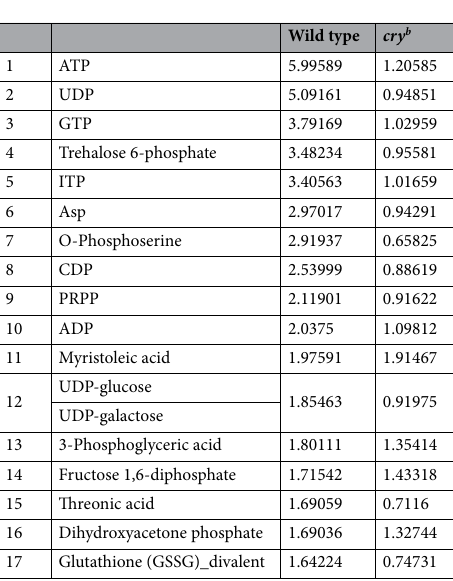
Table 1. Top 17 compounds upregulated in WT fly to cry mutant fly by EF exposure. Abundance of ATP is much more ca. 5.0-fold higher in WT than cry